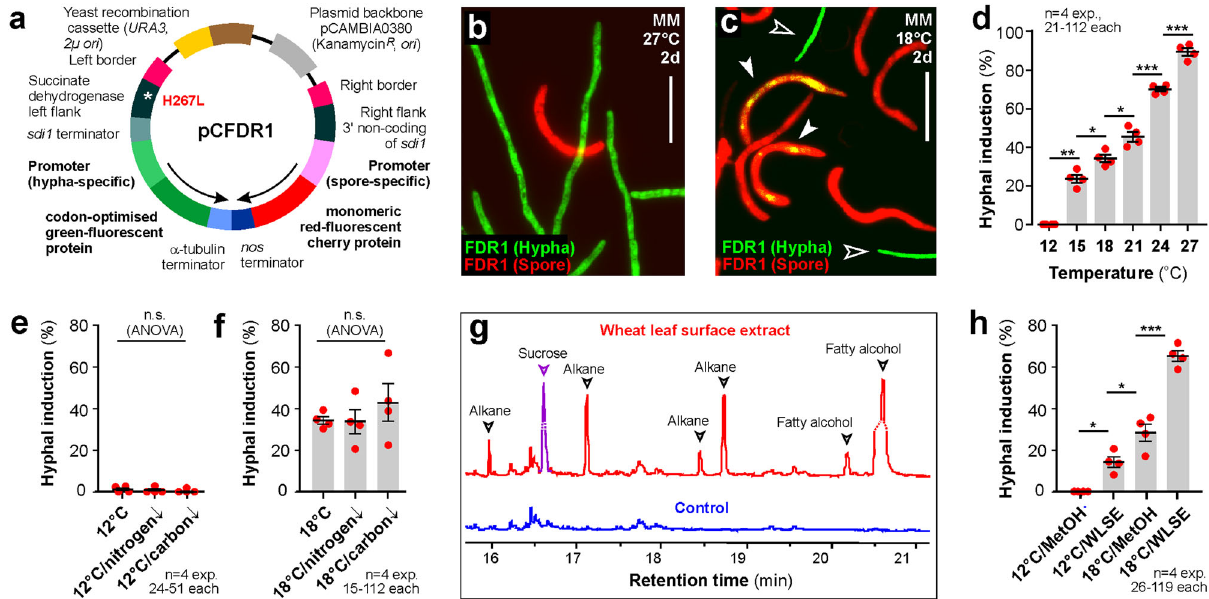
Fig. 2 | A fl uorescent reporter to analyse dimorphic switching conditions. a Organisation of the reporter plasmid pCFDR1. Expression of mCherry and ZtGFP isdrivenby1000bppromotersfromsporeandhypha-speci fi cgenes.Transcription direction indicated by arrows. The hygromycin resistance-conferring point muta- tionisindicatedbyasteriskandH267L.Fornucleotidesequenceforthespore-and hyphal-speci fi c promoters see Source Data File. b IPO323 cells expressing pCFDR1 (IPO323_FDR1) after 2 days of growth in MM at 27°C. Hyphae express codon- optimisedZtGFP(green),whereassporesexpressmCherry(red).Scalebar=30 µ m. See Supplementary Fig.3. c IPO323_FDR1 after 2days in MM/18°C. Fewhyphaeare formed(openarrowhead,green);somesporesshowexpressionofZtGFP(yellowin overlay; closed arrowhead), suggesting they are transitioning to hyphae. Scale bar=30 µ m. See Supplementary Fig. 3. d Hyphal programme induction, visualised by ZtGFP expression in IPO323_FDR1, after 2-day growth in MM at increasing temperatures. See also Supplementary Fig. 3. e , f Hyphal programme induction, visualised by ZtGFP expression in IPO323_FDR1, grown for 2 days in carbon- and nitrogen-free minimal medium at 12°C ( e ) and 18°C ( f ). Control experiments used minimalmedium. g GC-MSspectraofwheatleafsurfaceextract(WLSE)andsolvent alone (Control). WLSEs contain several compounds that are absent from the con- trol spectrum (arrowheads). The sucrose peak (purple) was manually added